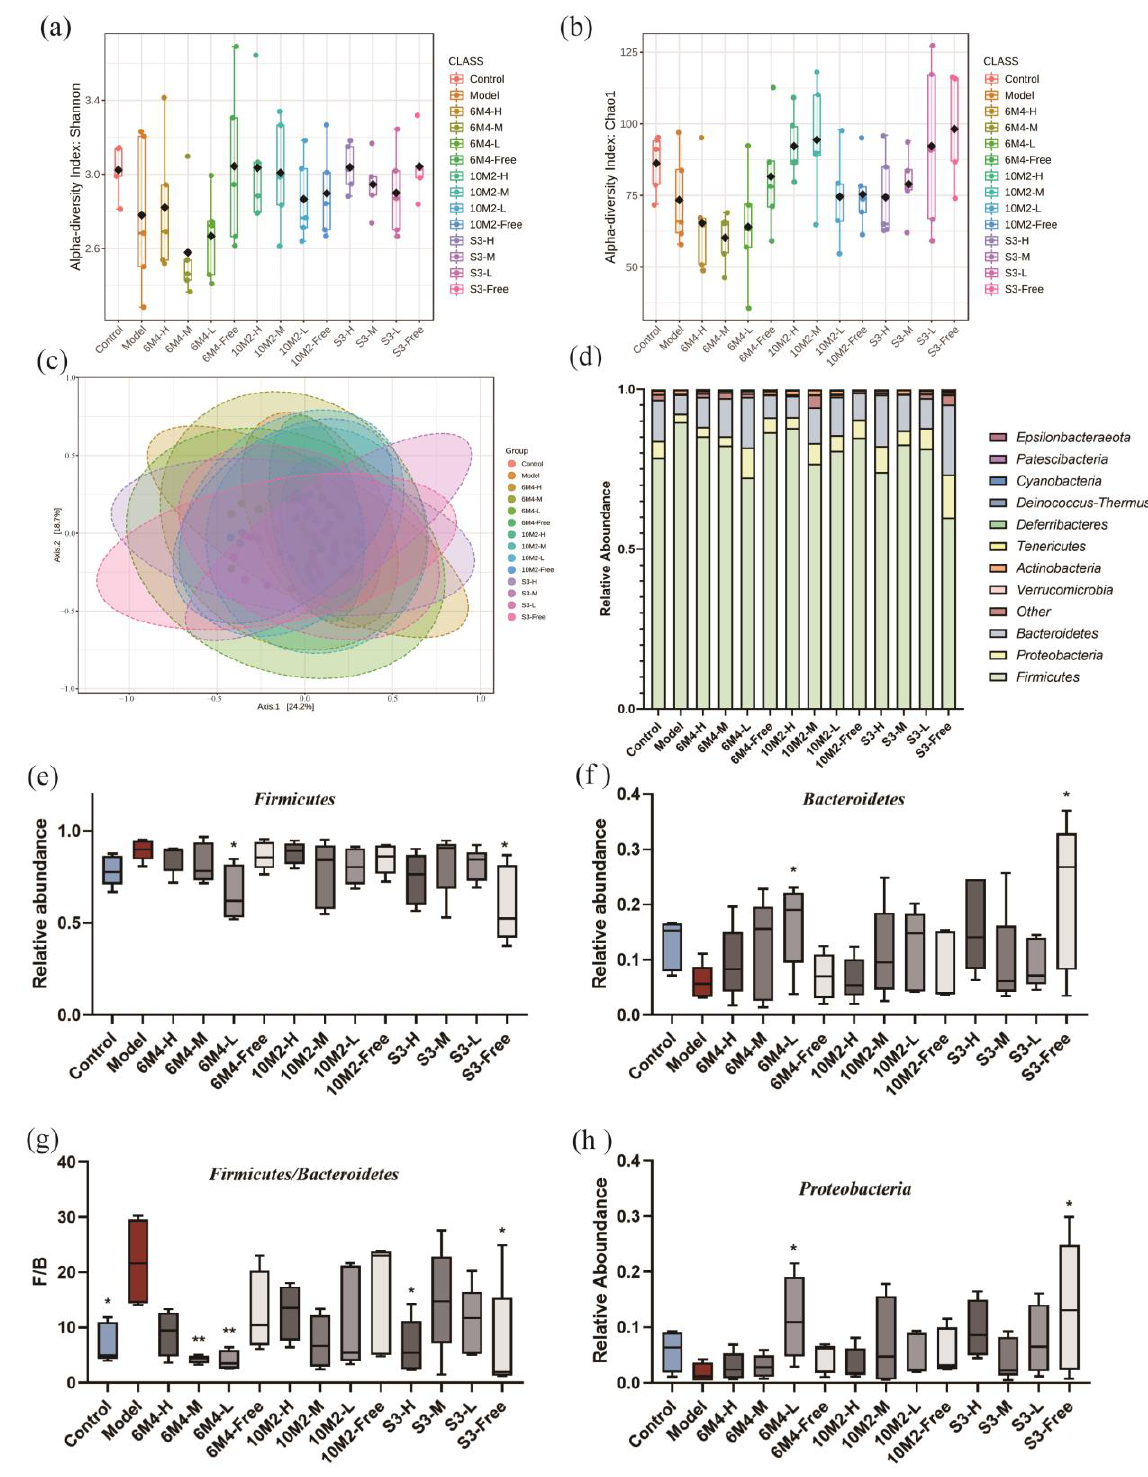
Figure 5. The composition of intestinal flora was changed after being given different doses of B . longum . ( a ) Shannon index of α -diversity; ( b ) Chao1 index of α -diversity; ( c ) principal coor- dinate analysis (PCoA) of the microbial group indicating β -diversity; ( d ) relative abundance of phyla; ( e – h ) relative abundance of Firmicutes, Bacteroidetes, Firmicutes/Bacteroidetes, and Actino- myces. Data are shown as means ± standard deviations. * p < 0.05, ** p < 0.01, compared with the model